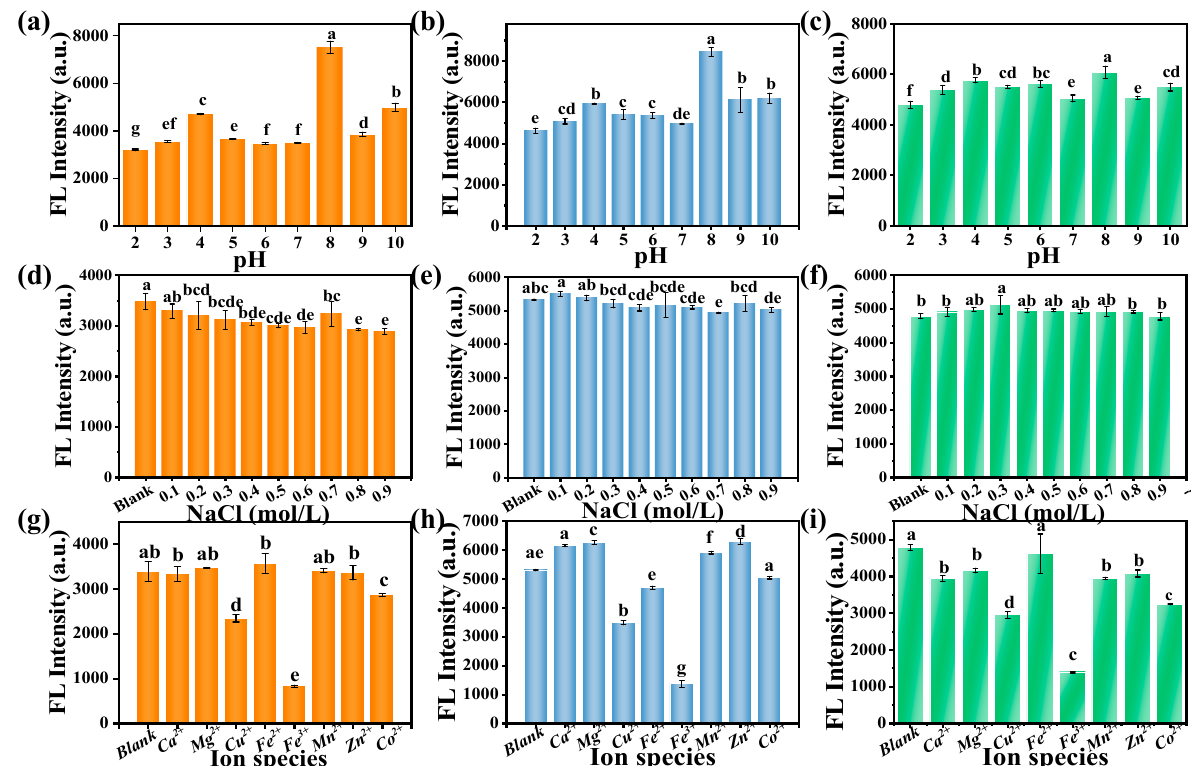
Figure 6. Effects of pH on the fluorescence (FL) intensity of ( a ) 140-CDs; ( b ) 160-CDs; ( c ) 180-CDs. Effects of the NaCl concentration on the fluorescence intensity of ( d ) 140-CDs; ( e ) 160-CDs; ( f ) 180-CDs. Effects of metal ions on the fluorescence intensity of ( g ) 140-CDs; ( h ) 160-CDs; ( i ) 180-CDs. Different lowercase letters ( a – g ) represent significant difference ( p < 0.05). Taken together, the fluorescent CDs synthesized with mussels will be a potential fluorescent probe in the future. In this study, mussels-derived CDs prepared at 180 ◦ C were used as bio-imaging and biosensor probes. Firstly, to estimate the biocompatibility of mussels-derived CDs, the viability of HepG2 cells treated with different concentrations of 180-CDs was eValuated. As shown in Figure S3, eVen though the concentration of 180-CDs increased to 6 mg/mL, the viability of HepG2 cells could still remain above 100% after incubation with CDs for 24 h. The result proved that mussels-derived CDs had excellent biocompatibility. Then, the 180-CDs were applied in onion epidermal cells and HepG2 cells for bio-imaging in vivo. Compared to the control, cell walls of the onion epidermal cells were fluorescent (Figure 7a), indicating that mussels-derived CDs could not cross the cytomembrane, which was consistent with pizza-derived CDs [38]. As seen in Figure 7b, HepG2 cells exhibited noticeable bright fluorescence after being treated with 180-CDs for 24 h, and mussels-derived CDs mainly localized in the cytoplasm of HepG2 cells. It was reported that endocytosis was the pathway for the cellular uptake of CDs [39]. Thus, mussels-derived CDs are excellent probes for cellular imaging